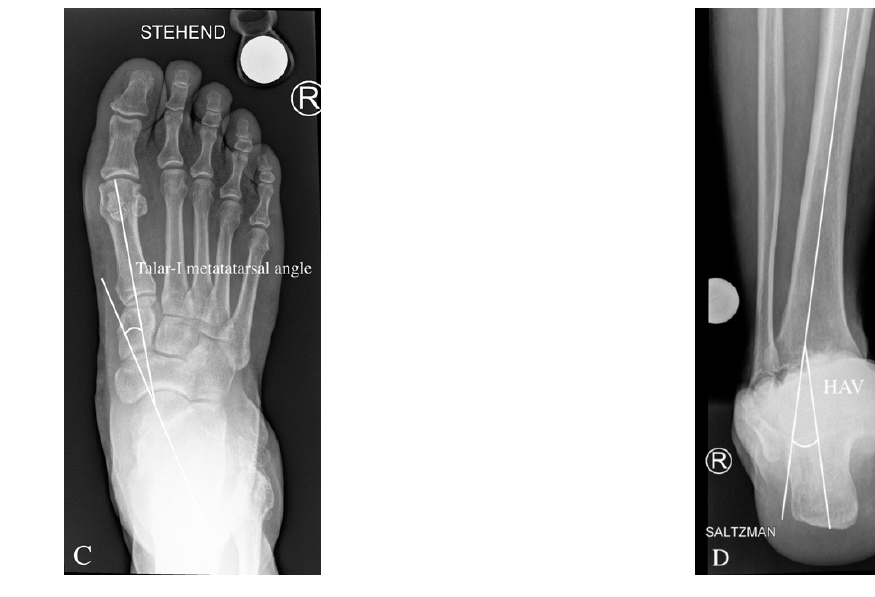
Figure 1. Angles for the Radiological Evaluation of a Varus Ankle Osteoarthritis. On the anteroposterior view, tibial anterior surface angle TAS (also known as medial distal tibial angle MDTA) tibiotalar surface (TTS) and talar tilt (TT) angle are shown ( A ). On lateral ankle radiograph, the tibial lateral surface angle (TLS) is assessed ( B ). The talar-1st metatarsal angle gives us a hint about the amount of midfoot deformity, both on lateral and dorsoplantar view ( B , C ). Inframalleolar deformity can be evaluated on the Saltzman view by measuring the hindfoot alignment view (HAV) angle ( D ). Further, in the ap view, the tibiotalar surface angle (TTS; normal range; 87.2 ± 2.8